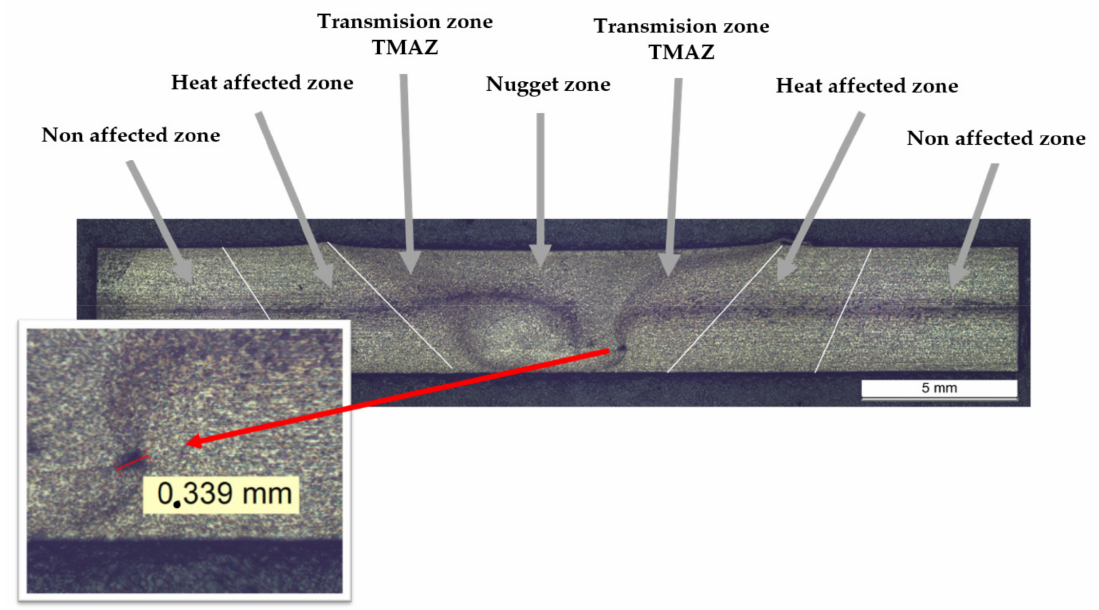
Figure 15. Cross section of a weld with tool 1-15-0; joint gap 0.6